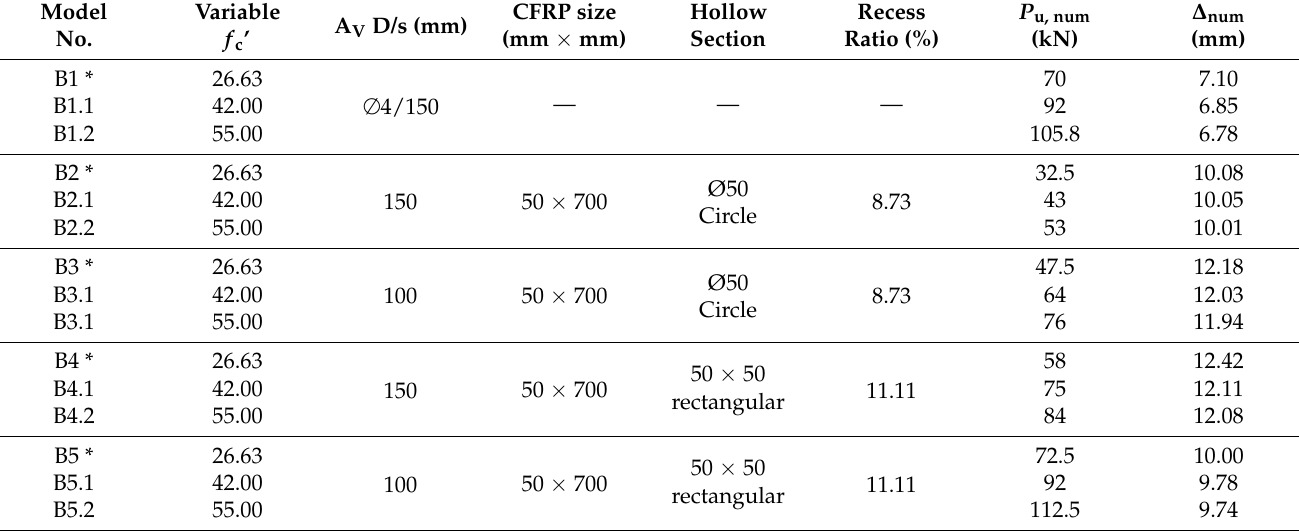
Table 7. Effects of the concrete cylinder compressive strength on the ultimate loads and mid-span deflections.